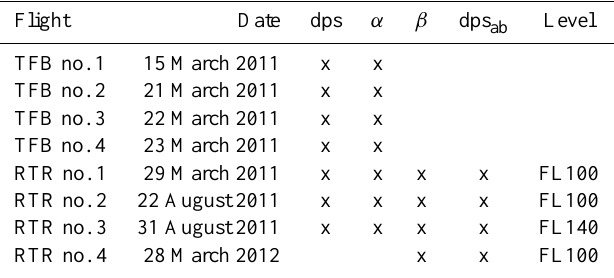
Table 4. List of the calibration flights performed for the static and dynamic calibrations of the Caravan measurement system. Four tower-flyby (TFB) and four racetrack (RTR) flights were conducted to parametrise the static pressure error (dps), the attack angle ( α ), the sideslip angle ( β ) and the dynamic pressure error (dps ab ). The TFB flights were conducted near ground (e.g. ∼ 30m above the run- way), the RTR in flight levels FL100 and FL140 (e.g. ∼ 3000 and ∼